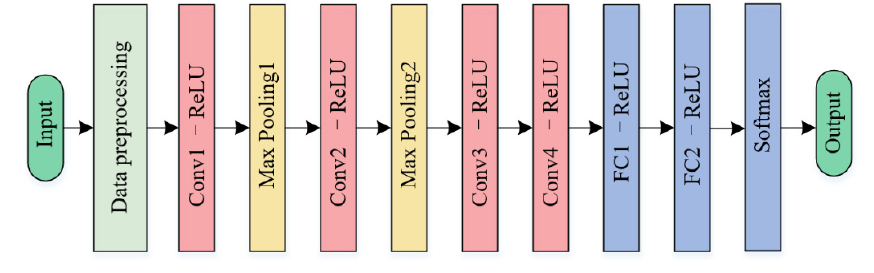
Figure 4. Visualization of feature maps within different convolutional layers: ( a ) First; ( b ) second; ( c ) third; and ( d ) fourth.